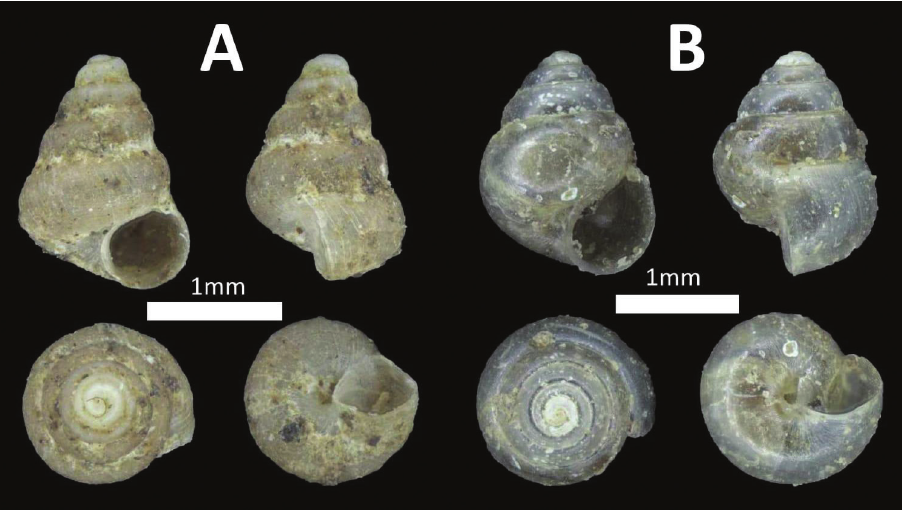
Figure 2. Family Assimineidae. A Acmella striata (BOR/MOL 7173) B Acmella polita (BOR/MOL 12243).